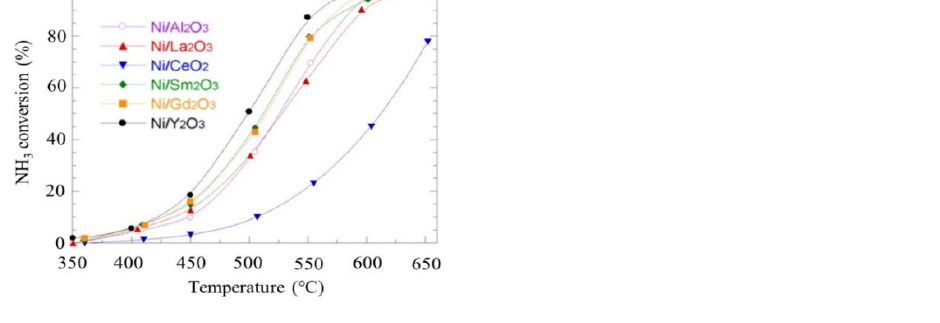
Figure 36. Ammonia cracking over Ni-based catalysts at different temperatures from 350 to 650 °C. the highest ammonia conversion rate at different temperatures reached with Ni/Y 2 O 3 . Reprinted with permission [111].